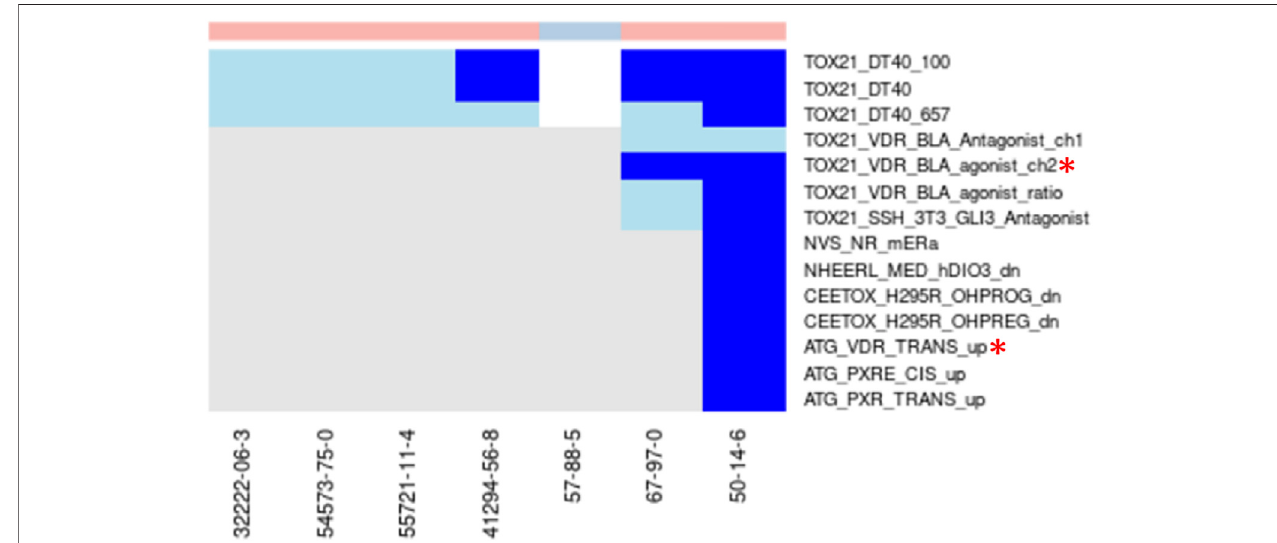
FIGURE7| Vitamin-Danalogs.Combinedheatmapshowingchemicalsfromclusters1798and1964containingvitamin-Danalogs.Allassayscorrespondingtothe vitamin-Dreceptorandanyotherassaywithactivitybelowthecytotoxicitypointforatleastonechemicalareshown.Heatmapcolors:blue=activebelowthecytotoxicity point, light blue = active above the cytotoxicity point, white = inactive, grey = not tested. Top of heatmap: red = toxic, blue = nontoxic, aquamarine = unde fi ned. Red asterisks identify the assay(s) selected for that cluster.